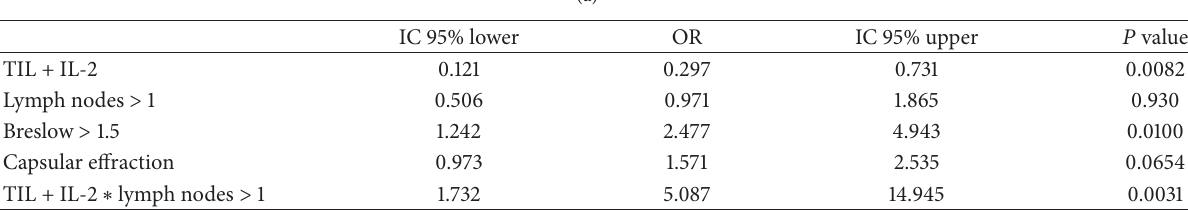
Table 3: (a) Cox model for the relapse-free survival adjusted on prognosis factors. (b) Cox model for the overvall survival adjusted on prognosis